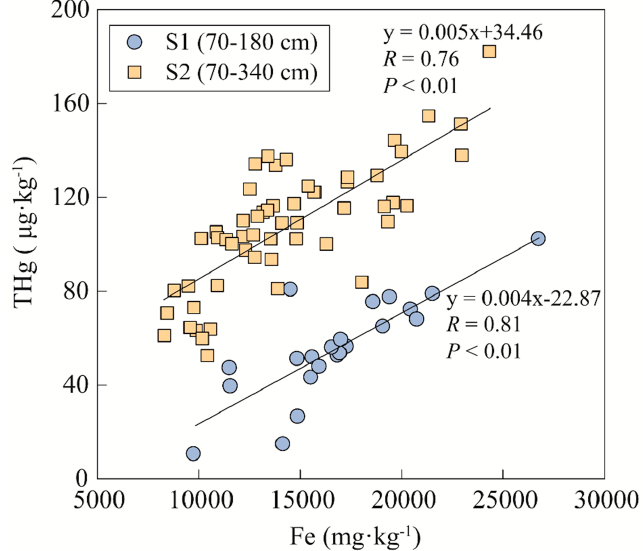
Figure 5. Line regression relationships between the Fe content and THg content in the lower layers (>70 cm) of both forest profiles.